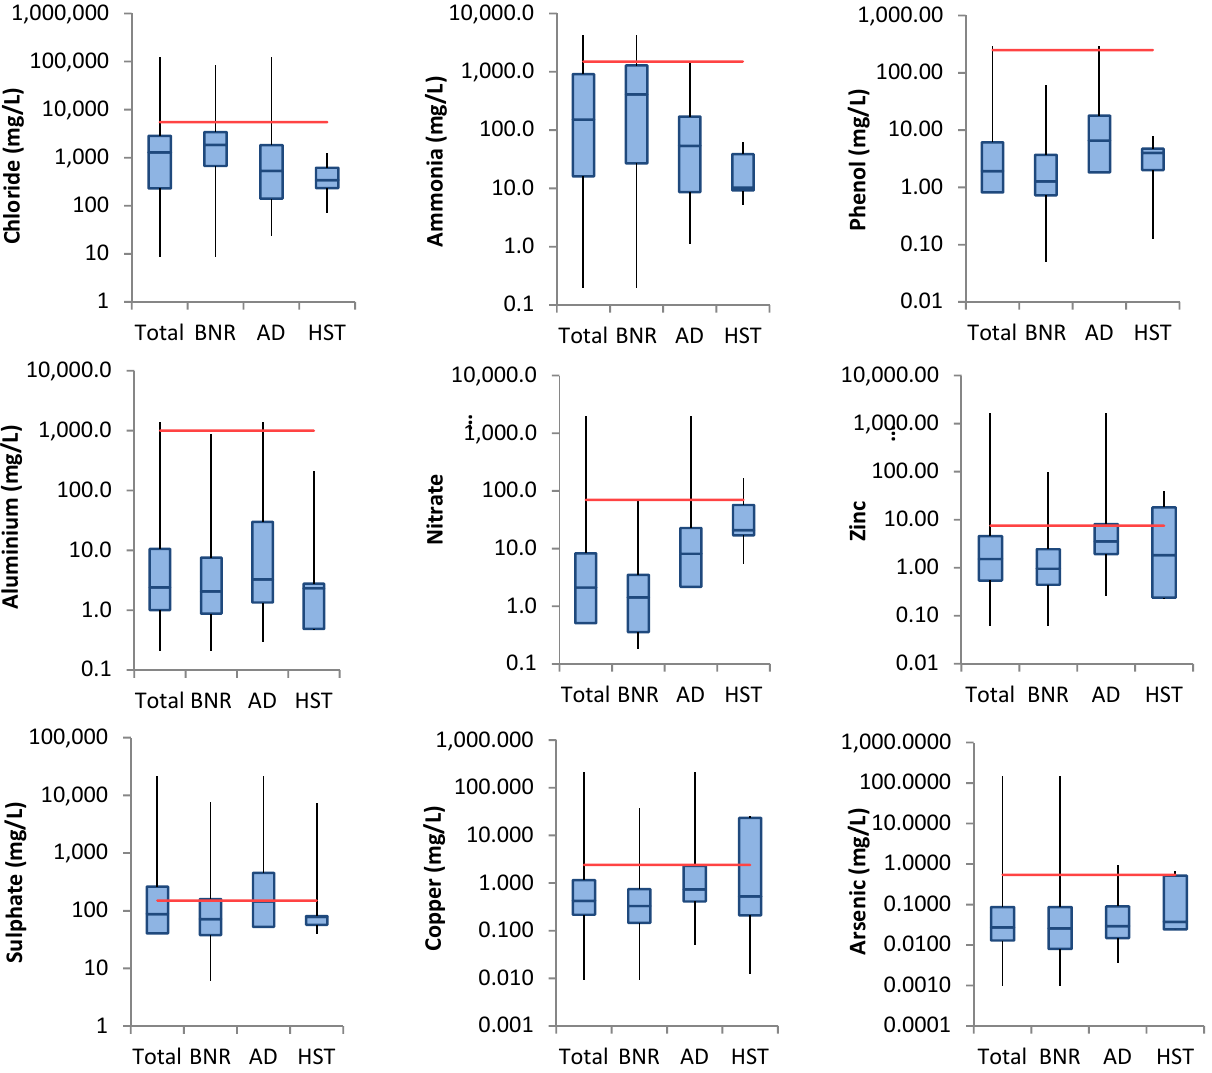
Figure 3. Box and whiskers plot values representing TWs’ composition depending on the treatment route generally chosen by water utilities. BNR represents TWs with COD below 50 g/L that are typically fed at the head of wastewater treatment plants, AD represents TWs with a COD between 50 and 250 g/L that go directly to the AD, and HST represents TWs with COD above 250 g/L that normally go to high-strength tanks. The lowest inhibitory value for AD reported in the literature is represented by the red lines (Table S1 in Supplementary Materials). The lowest point in the whisker represents the minimum value of the data, the highest point on the whisker represents the maximum value, the bottom of the box is the 25 percentile, the top of the box is the 75 percentile and the line dividing the box is the